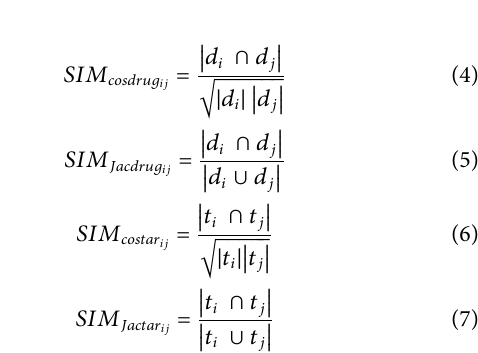
FIGURE 1 | Reinforcement